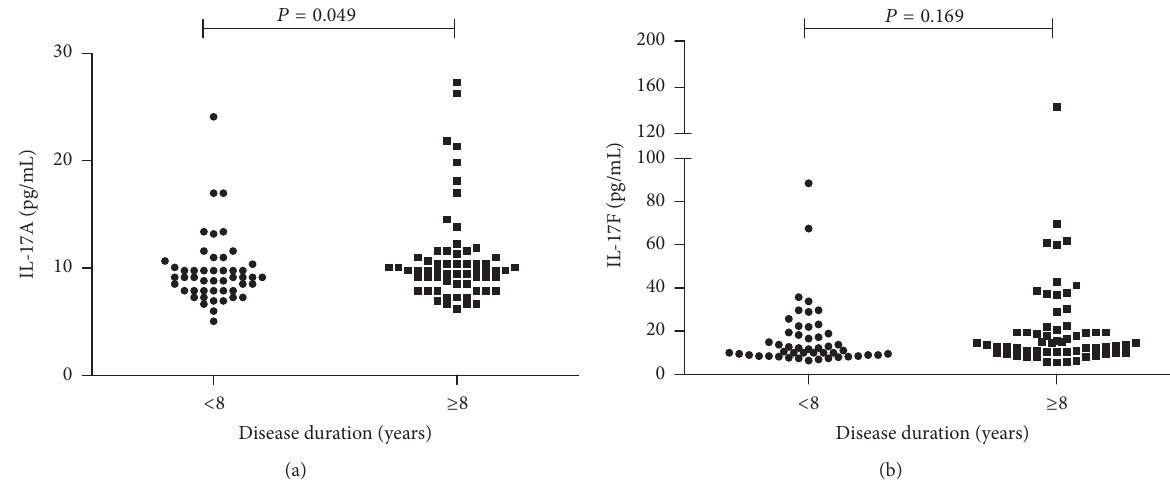
Figure 4: Comparison of serum levels of IL-17A and IL-17F between pSS patients with longer disease duration ( ≥ 8 years) and shorter disease duration ( < 8 years). (a) Serum IL-17A levels were significantly elevated in pSS patients with a longer disease duration. (b) Serum IL-17F levels were not significantly elevated in pSS patients with a longer disease